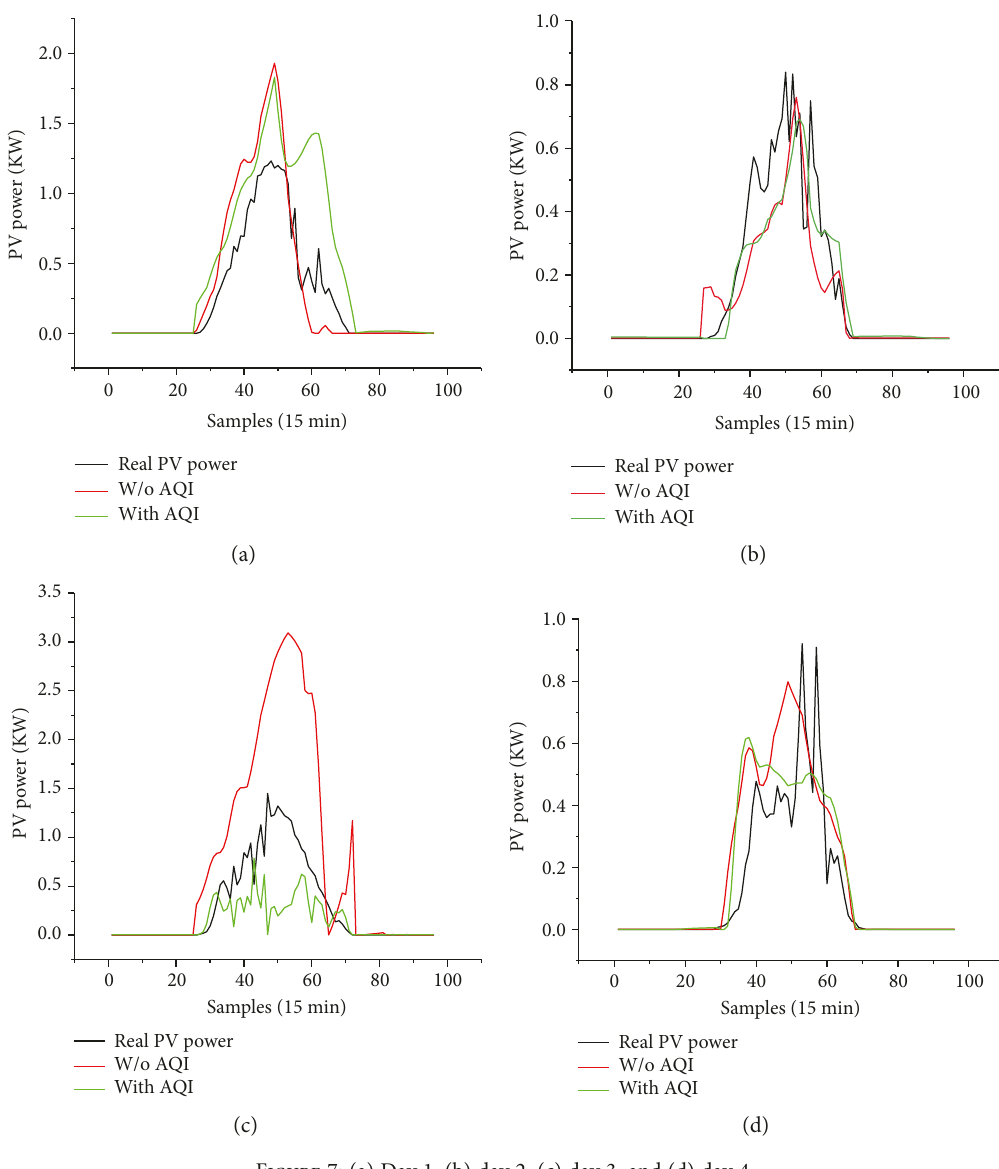
Figure 7: (a) Day 1, (b) day 2, (c) day 3, and (d) day